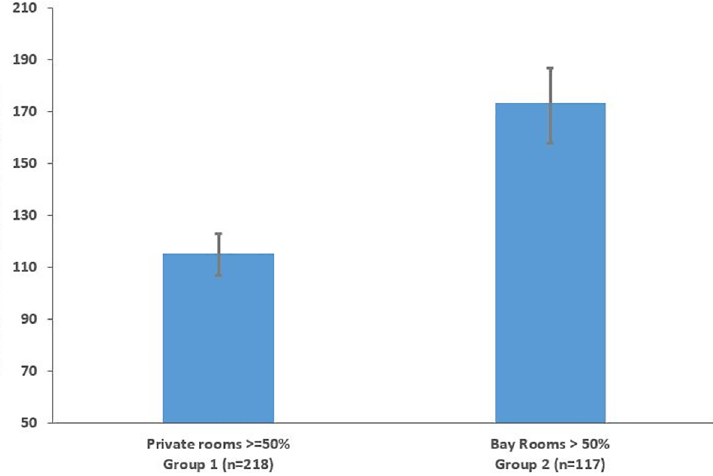
Fig 1. Rate of central-line bloodstream infections at 335 Texas hospitals. Group 1 Hospitals have majority private rooms. Group 2 Hospitals have majority bay